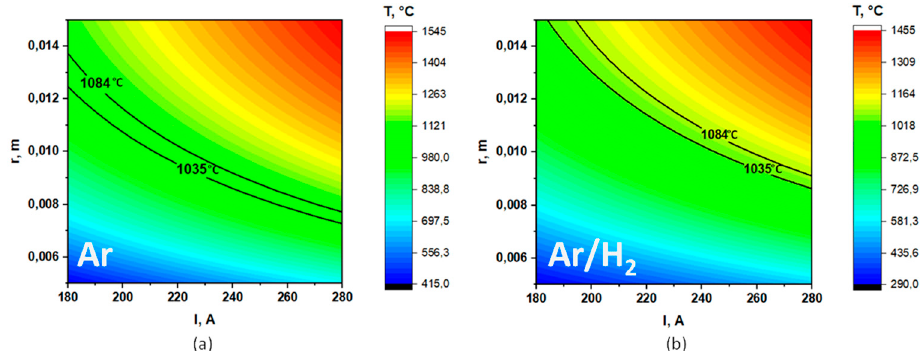
Figure 15. Simultaneous effect of copper foil size and electrical current intensity on substrate temperature: ( a ) Pure argon; ( b ) Mixture of 500 sccm argon with 100 sccm H 2 .